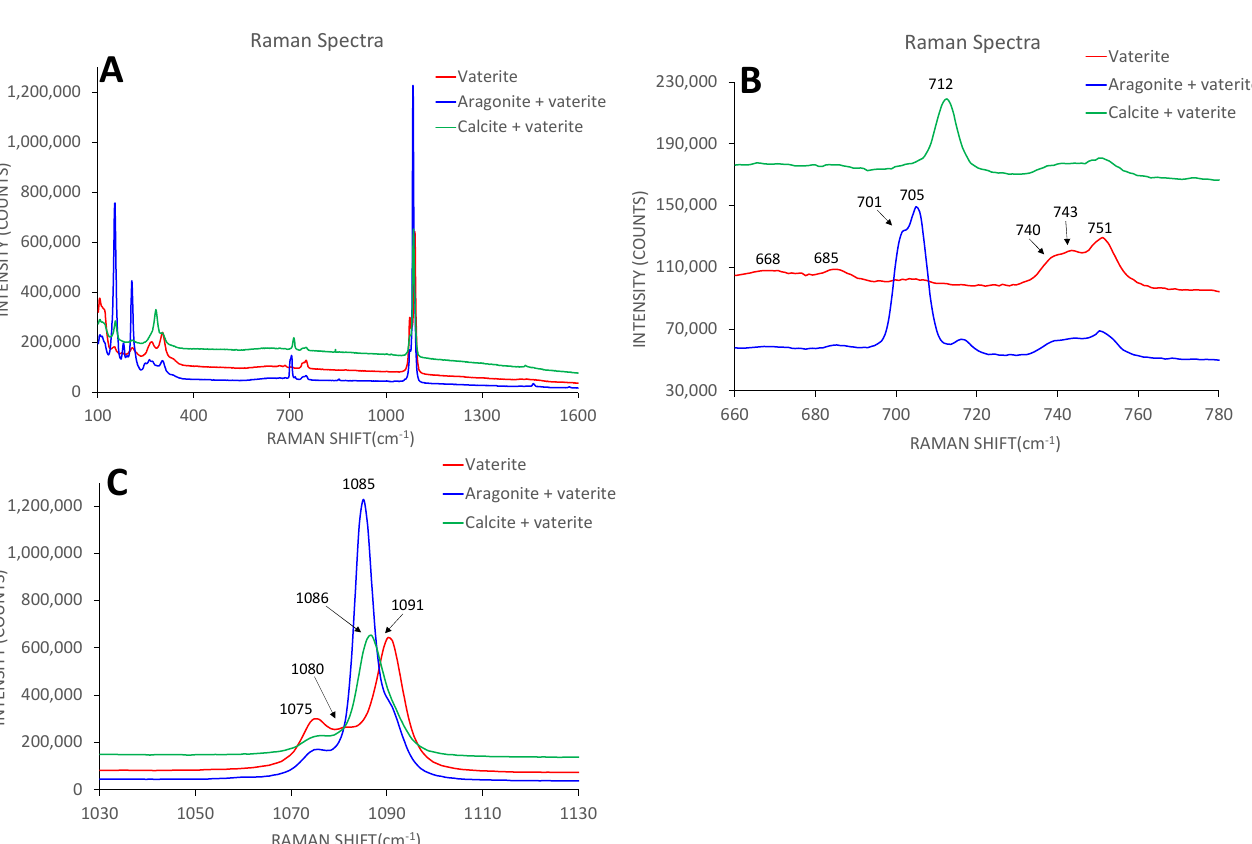
Figure 31. ( A ) Raman spectra of vaterite (orange), dominant aragonite with minor vaterite bands (blue), dominant calcite with minor vaterite bands (green). ( B ) The most intense bands correspond to ʋ 1 of vaterite showed at 1075, 1080, and 1091 cm −1 whereas in aragonite and calcite spectra displayed at 1085 cm −1 and 1086 cm −1 , respectively. ( C ) The ʋ 4 of vaterite showed as weak bands at 667, 685, 740, 743, and 751 cm −1 . Doublet bands at 701 and 705 cm −1 belong to aragonite and a single band at 712 cm −1 indicates calcite. The mixture of different polymorphs in the same spectra was presented. The dominant vaterite spectrum contain a tiny band of aragonite at 702 cm −1 , and the vaterite bands at 685, 740, 743, 751, and 1075 cm −1 (shoulder) are presented in the dominant aragonite calcite spectra.